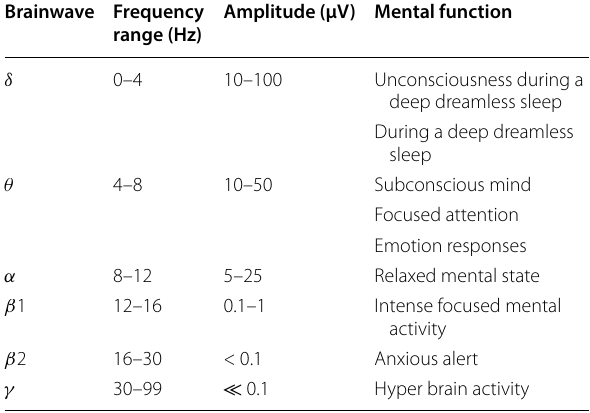
Amplitude values measured during data collections